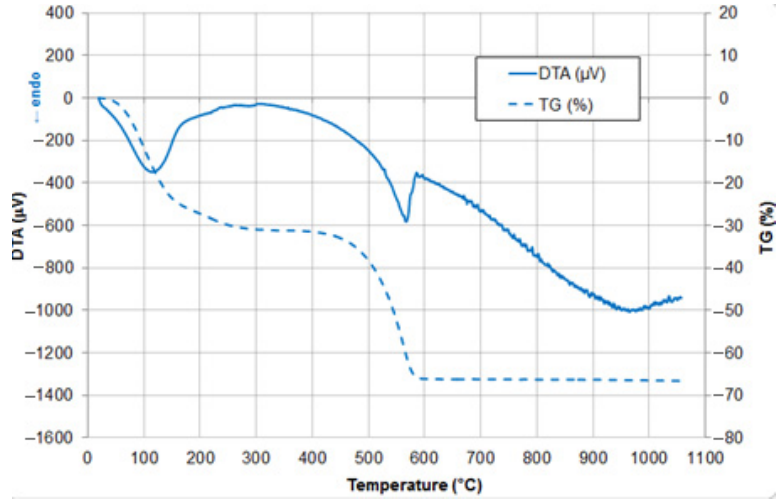
Figure 9. Thermogravimetric (TG) and differential thermal analysis (DTA) curves of the sample WFS/0 (original waste Fe sludge).